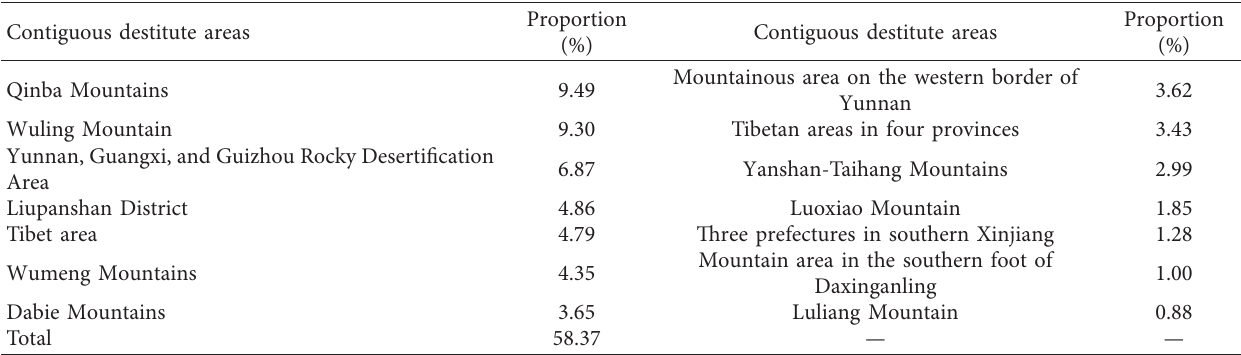
Table 3: The distribution of pro-poor tourism villages in contiguous destitute